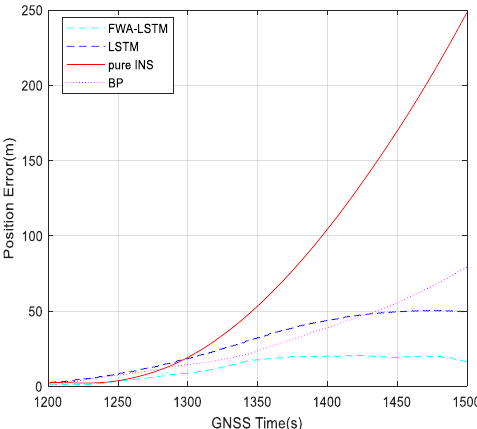
Figure 17. Position errors during 1200~1500 s with different algorithms.